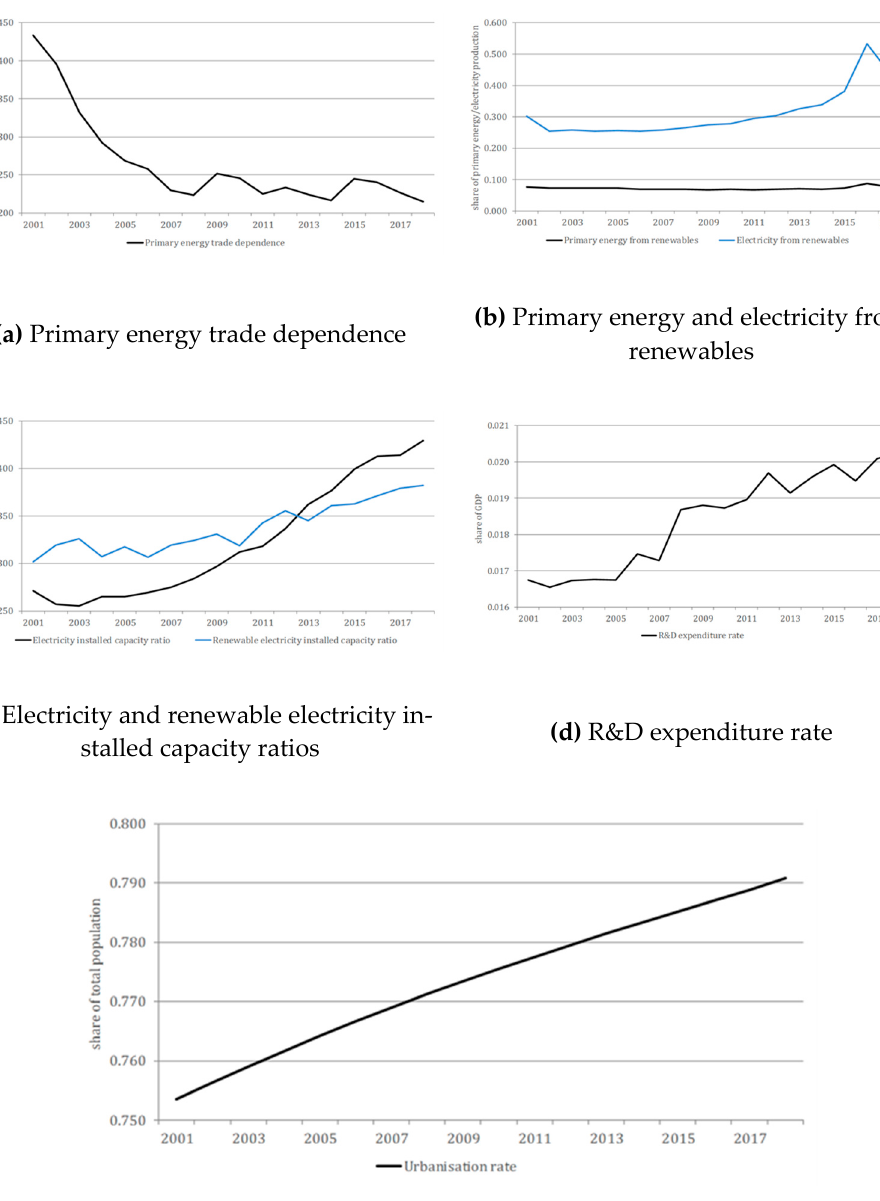
Figure A1. Time evolution of the input variables.